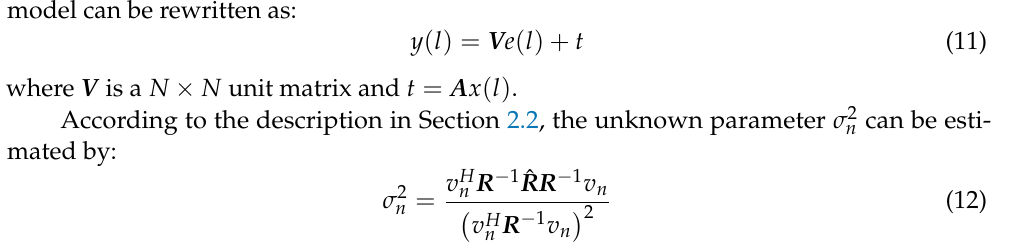
2. Moreover, the “convergence” in both Tables 1 and 2 is